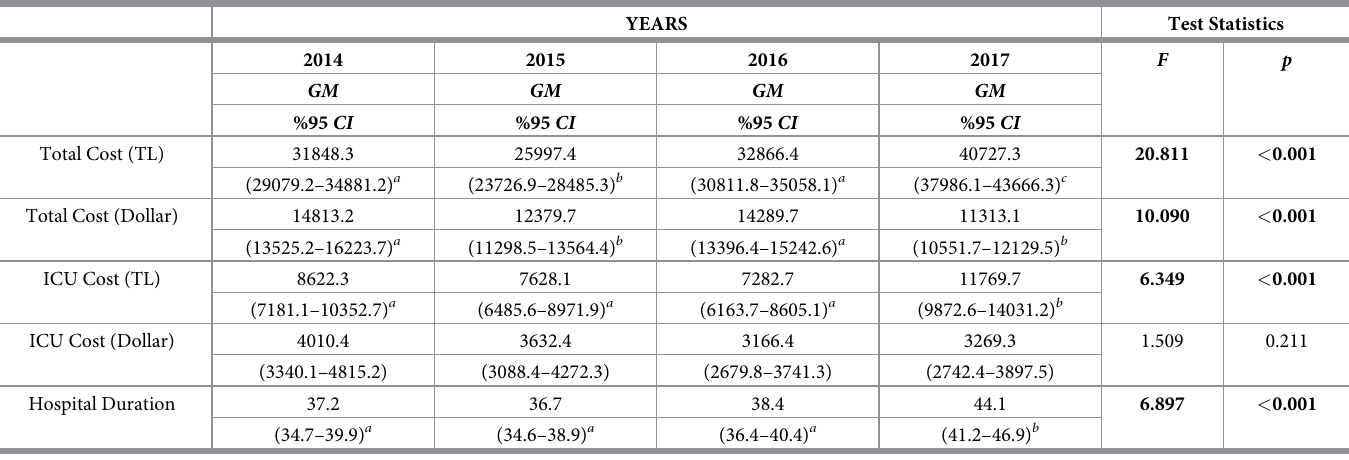
Table 2. Comparison of costs by